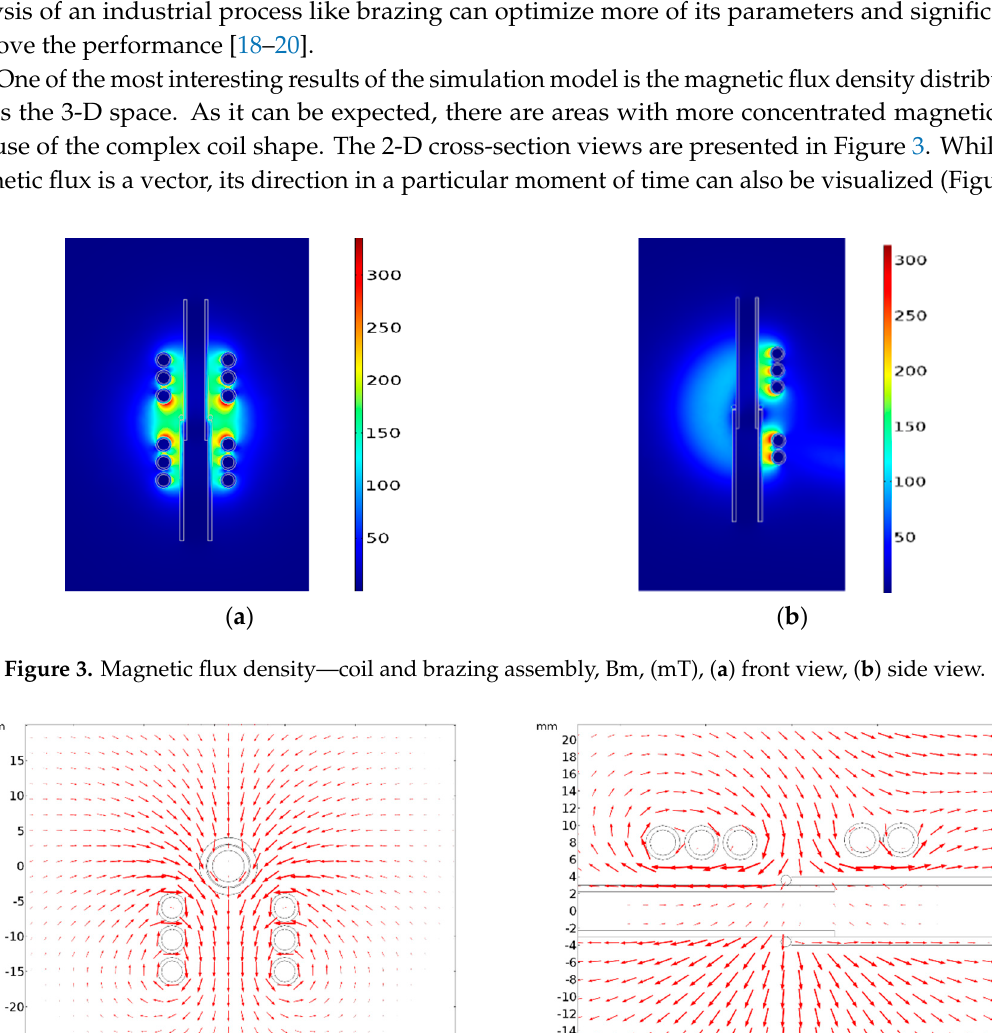
Figure 5. Current density (copper), ( a ) brazing assembly, ( b ) coil. Magnetic flux causes a “footprint” of electric current density over the brazing assembly presented on Figure 5a. It can be directly related to the resulting heat source (Figure 6a).